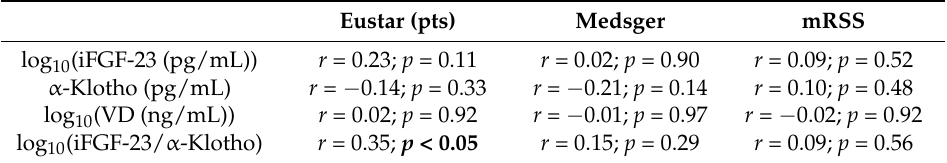
Figure 1. Correlation between the log 10 FGF23/ α -Klotho index and disease activity (Eustar 2017) in systemic sclerosis patients (FGF/ α -Klotho values were presented with logarithmic normalization due to skewed data distribution). Table 3. The Pearson correlation coefficient and significance level between Vitamin D, FGF 23, Klotho and FGF23/Klotho index and disease activity scales (mRSS, Eustar, Medsger) in patients with SSc.